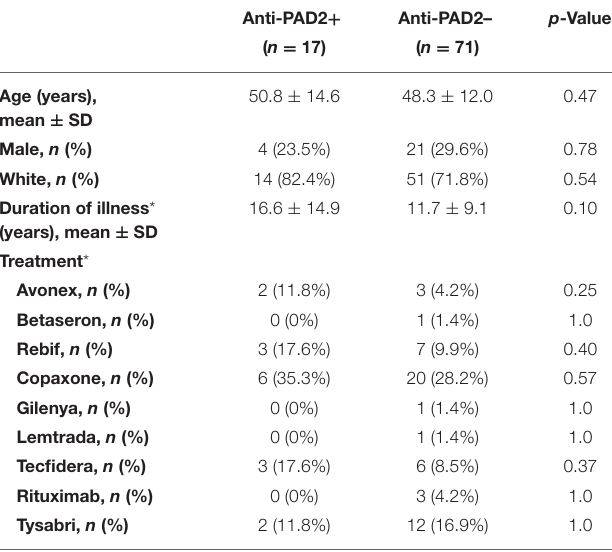
TABLE 2 | Characteristics of people with MS according to anti-PAD2 antibody status. Anti-PAD2 + Anti-PAD2–